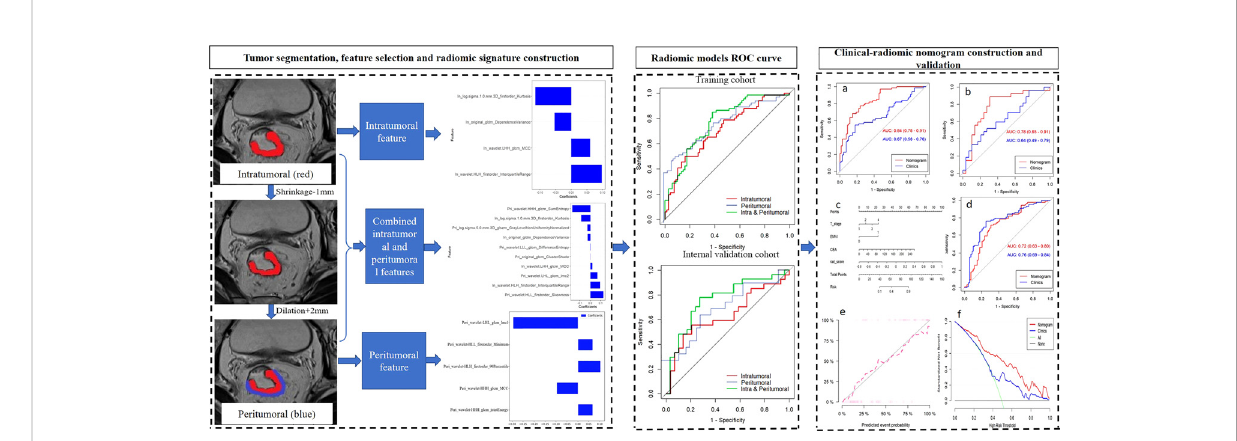
FIGURE 2 The work fl ow of a typical radiomics process in our study included tumor segmentation, feature selection, and model construction and